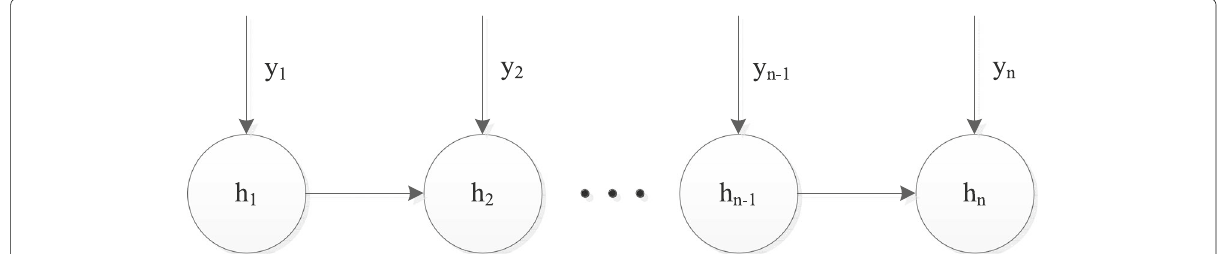
Fig. 5 Bayesian network representing the Markovian assumption applied in the Kalman